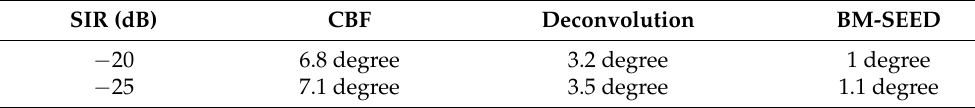
Table 1. Beamwidth (degree) under different SIR